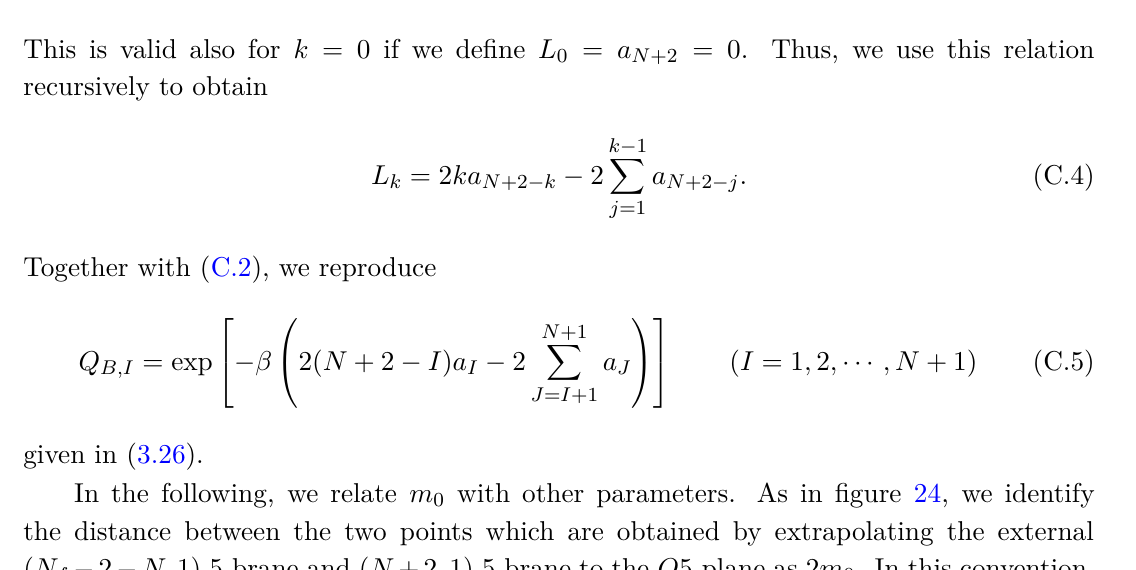
Figure 24 . Left: the computation of L N +1 . Right: the computation for the length X on the left